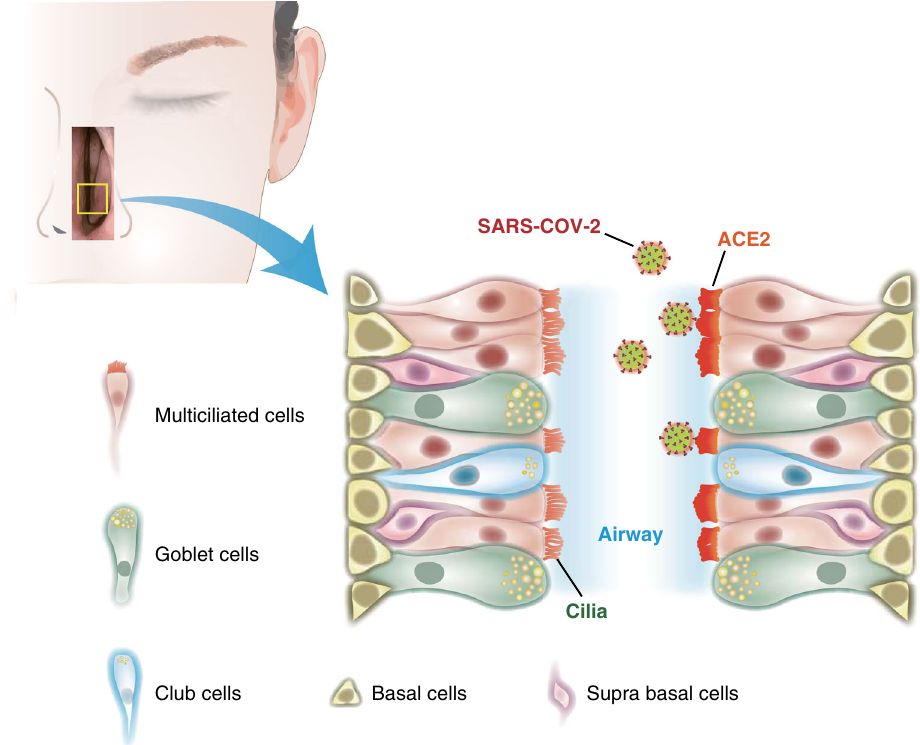
Fig. 7 Illustration of ACE2 expression in the motile cilia of epithelial cells in the nose, paranasal sinuses, trachea, and lower airways. The luminal differentiated airway epithelial cells consist of ciliated columnar cells (~80%) and secretory goblet cells (~20%). Club cells are infrequently found in the human upper airway. The basal cell layer, which faces the lamina propria, is comprised of both basal and suprabasal cells, which are considered multipotent progenitors capable of renewing the airway epithelium. This schematic depicts how SARS-CoV-2 may bind to ACE2 expressed on the cilia of the nasal cavity following exposure to respiratory droplets or airborne